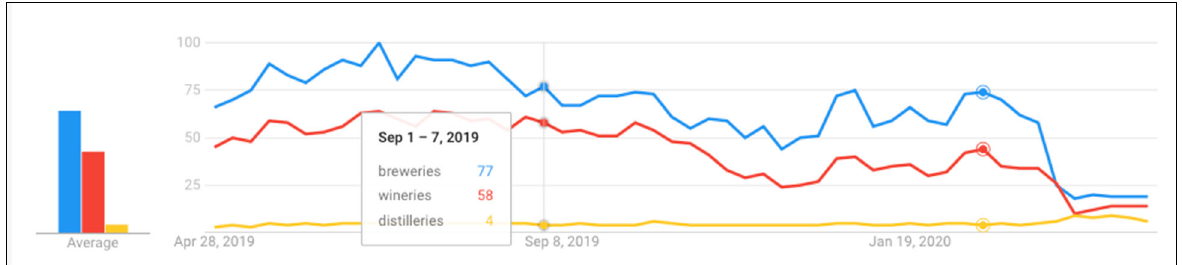
Source: Google Trends, April 27, 2020; the geography of search is the U.S.; circles to the right show week of February 16–22, 2020 as period of